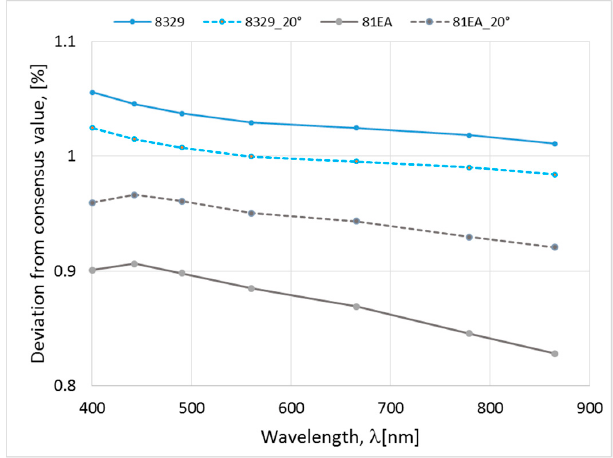
◦ with respect to the incident irradiance Figure 14. Effect of calibration with tilted to 20° with respect to the incident irradiance sensor. Figure 14. E ff ect of calibration with tilted to 20